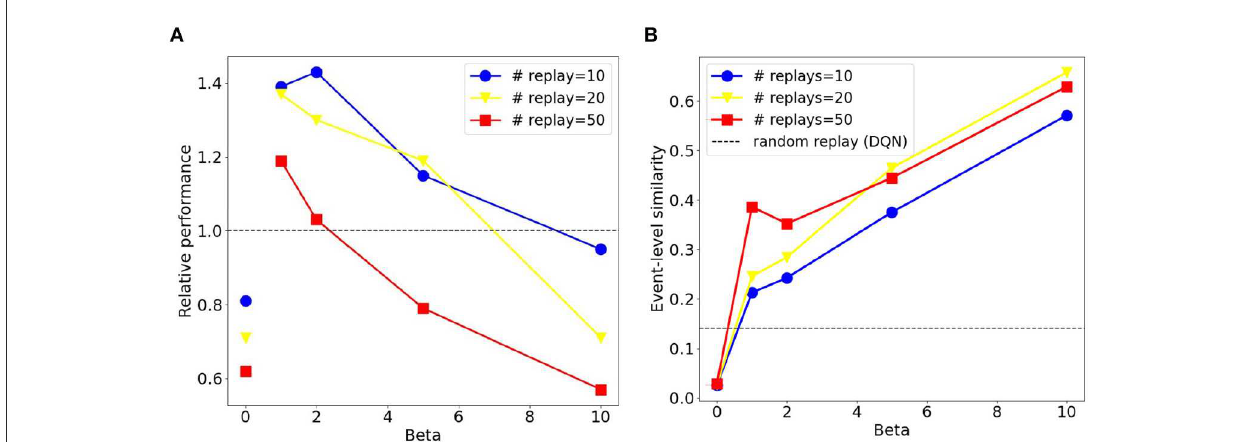
FIGURE12 Sequential replay outperforms random replay when the number of replays is limited and sequences are not deterministic. (A) Relative performance of sequential replay over random replay (inverse ratio of the average escape latency) for different combinations of inverse temperature β and replay number. Please note the discontinuity between the data points with β = 0 and those with other β -values. Each data point was averaged over 50 runs. (B) Average event-level similarity of the replay batches. The similarity index of two replayed batches was the proportion of same experience tuples that the two batches share. For one replay event, the similarity indices between any two pairs of batches were computed and then averaged, resulting the event-level similarity. Each data point in the figure was then the average of the event-level similarity over all replay events of the first 200 trials from all the 50